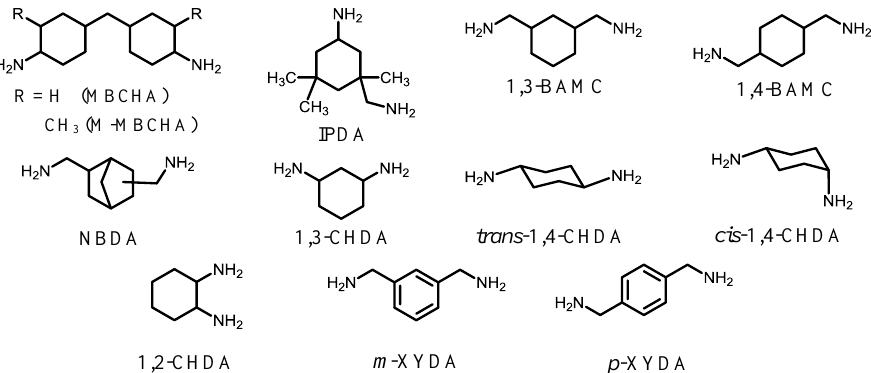
Figure 8. Commercially available aliphatic diamines.